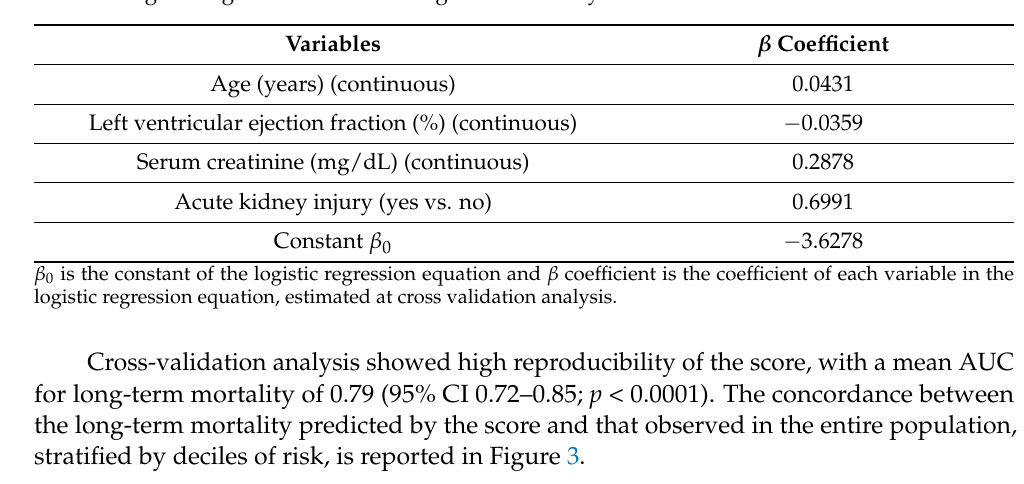
Figure 4. Left panel: receiving operating characteristic curve and corresponding area under the curve (AUC) for in-hospital mortality prediction of the risk score. Right panel: concordance be- tween the in-hospital mortality incidence predicted by the score and that observed in the entire population, stratified by deciles of risk.